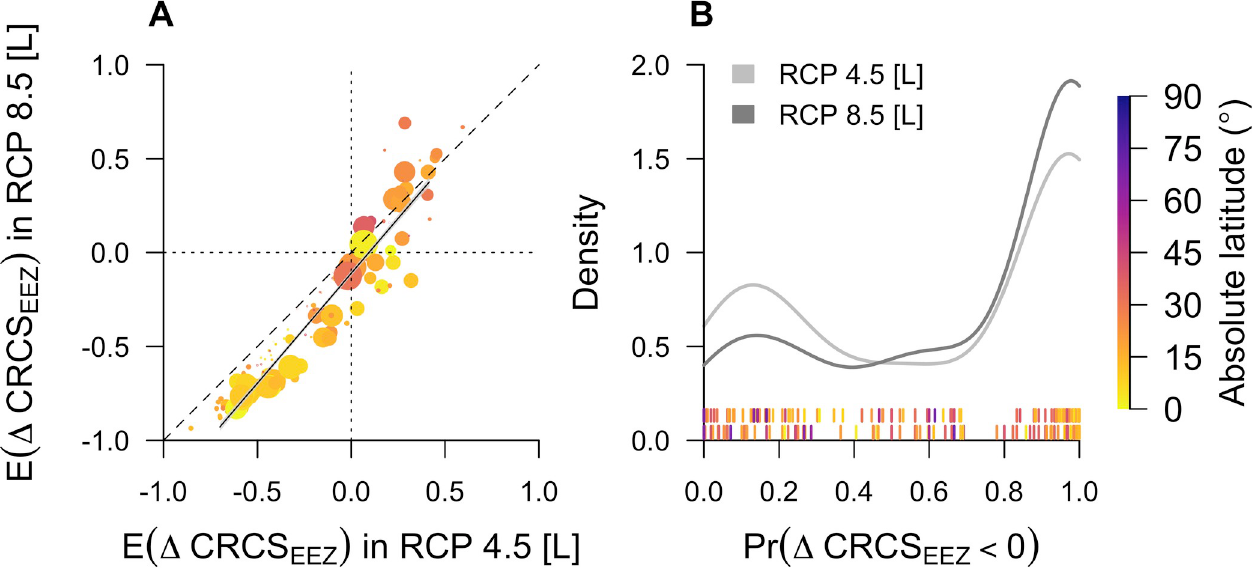
Fig 6. A comparison of predicted changes in the index of thermal habitat suitability (CRCS) between late-century climate experiments across Exclusive Economic Zones (EEZs). A, The mean predicted change in CRCS (E( Δ CRCS EEZ )) under RCP 8.5 as a function of the mean predicted change under RCP 4.5. B, Density distributions of the proportion of species predicted to experience declines in CRCS across EEZs (Pr( Δ CRCS EEZ < 0)). In A, each point represents an EEZ; point size is proportional to the number of modelled species. The diagonal dashed line represents the line y = x . The solid black line surrounded by the grey confidence envelope marks the robust regression line ± 95% confidence intervals. The vertical and horizontal dotted lines mark a mean predicted change in CRCS of 0 under RCP 4.5 and 8.5 respectively. For EEZs below the line y = x , the predicted change in CRCS under RCP 8.5 is more negative than under RCP 4.5. For EEZs above the line, the predicted change in CRCS under RCP 8.5 is more positive. In B, the light and dark grey lines represent RCP 4.5 and 8.5 respectively. The upper and lower rugs mark the proportion of species predicted to experience declines in each EEZ under RCP 4.5 and 8.5 respectively. In both panels, EEZs are coloured according to their (absolute) mid-point latitudinal location.